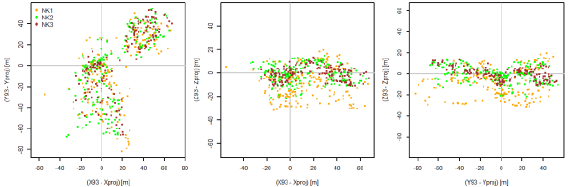
single peak, even though it is not centered and symmetric. The the translation in Y is tri-modal, with two possible candidates. inside the Cloud Compare software.